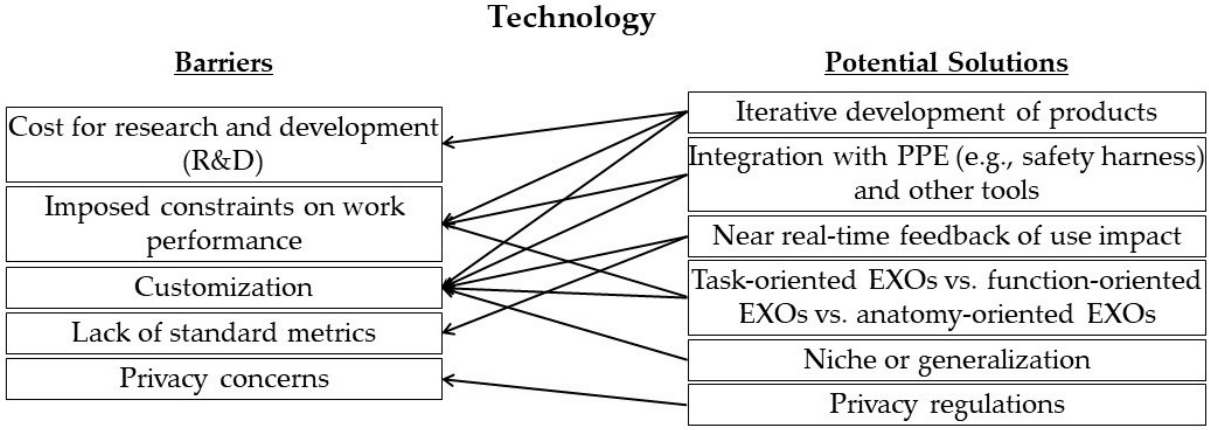
Figure 3. Mapping of potential solutions to identified barriers in the technology category.